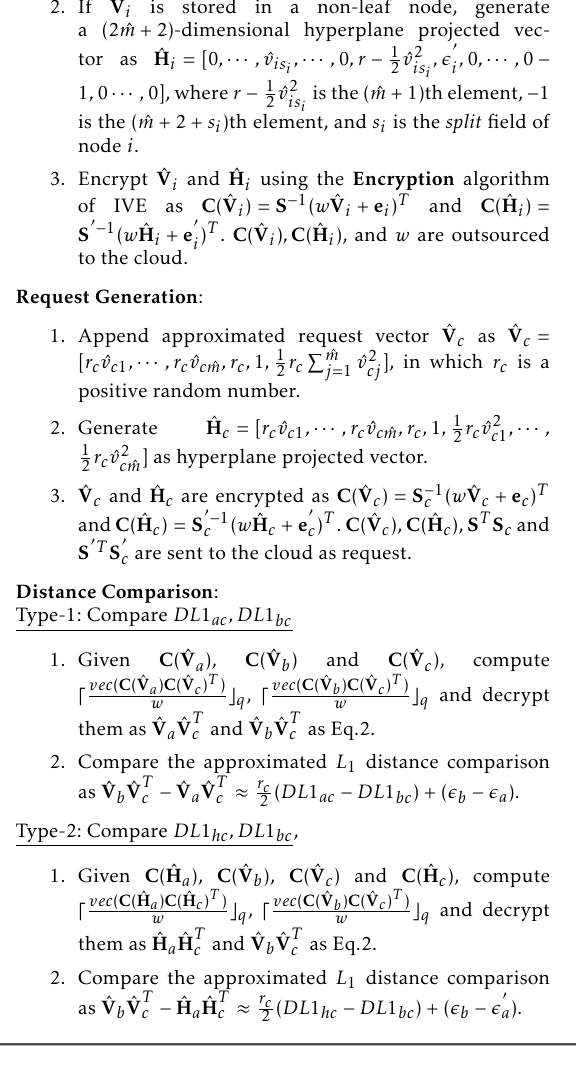
approximated distance comparison result scaled and (cid:48) obfuscated by r c , (cid:15) b − (cid:15) a and (cid:15) b − (cid:15) as shown in a 4.2. As r c is a positive random number, the sign of r c ( DL 1 ac − DL 1 bc ) and r c ( DL 1 hc − DL 1 bc ) are consistent 2 2 with DL 1 ac − DL 1 bc and DL 1 hc − DL 1 bc